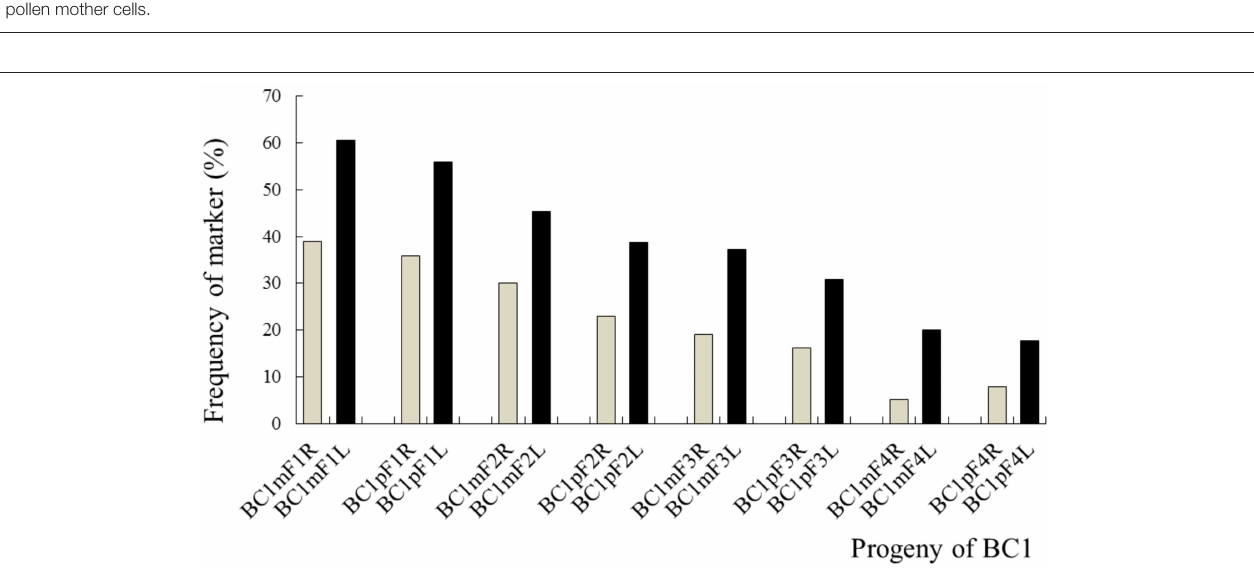
FIGURE 8 | Frequency of the marker specific to the C-chromosome of Brassica napus in the first- to fourth-generation progenies of BC1. BC1mF1R to BC1mF4R and BC1pF1R to BC1pF4R are the glyphosate-tolerant first- to fourth-generation progenies of the first backcross generation (BC1) obtained from wild Brassica juncea × F1R or F1R × wild B. juncea , respectively. BC1mF1L to BC1mF4L and BC1pF1L to BC1pF4L are the glufosinate-tolerant first- to fourth-generation progenies of the first backcross generation (BC1) obtained from wild Brassica juncea × F1L or F1L × wild B. juncea , respectively. F1R or F1L are the glyphosate- or